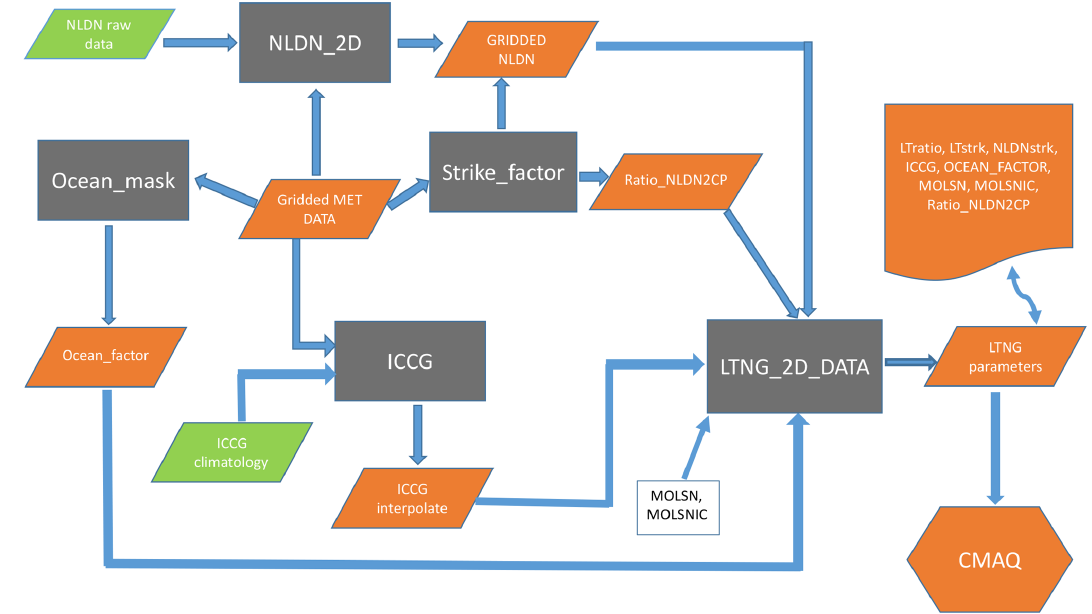
Figure 1. Flowchart of data preprocessing for LNO production in CMAQ for the mNLDN